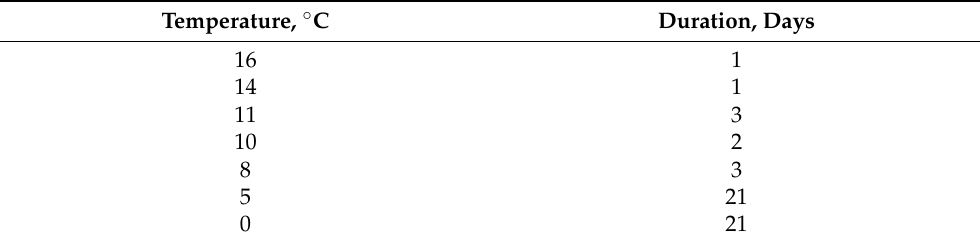
Table 2. Procedure for acclimation of Aglais urticae